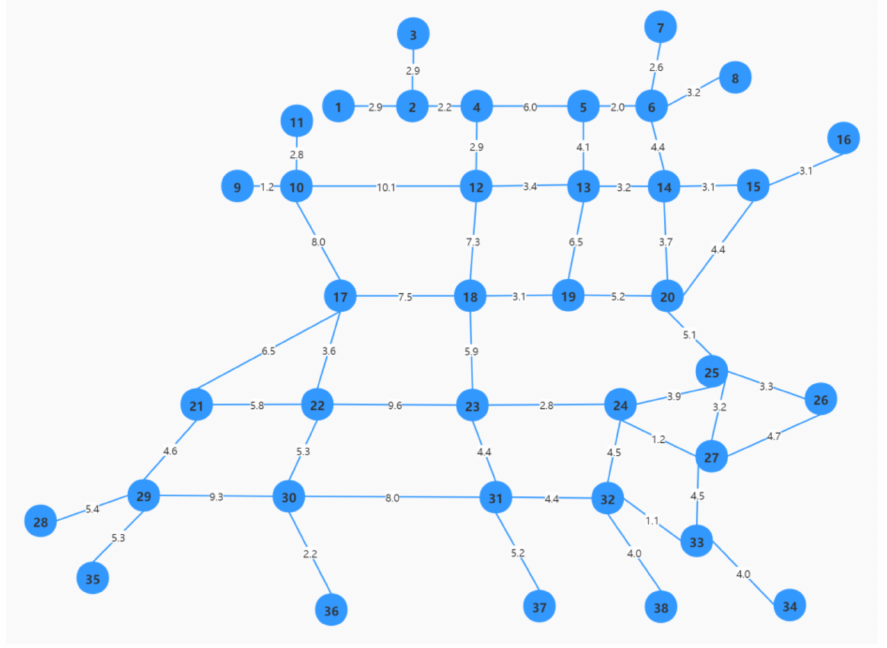
Figure 5. Road network in Songjiang District